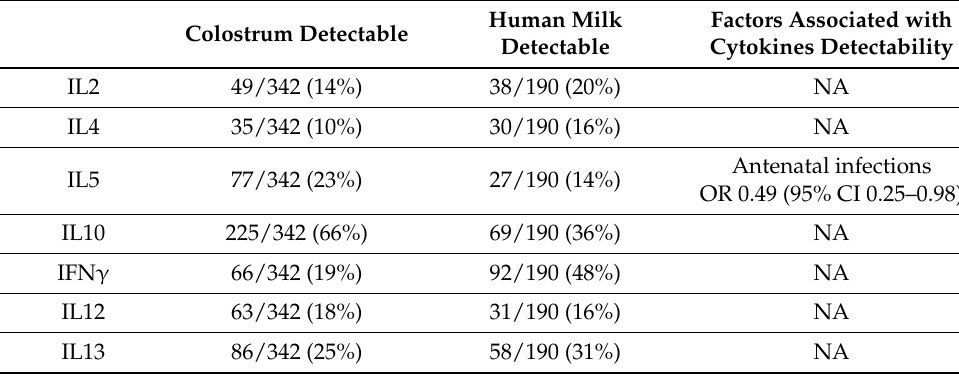
Table 4. Detectability of Th1 and Th2 Cytokines in Colostrum and Human Milk.